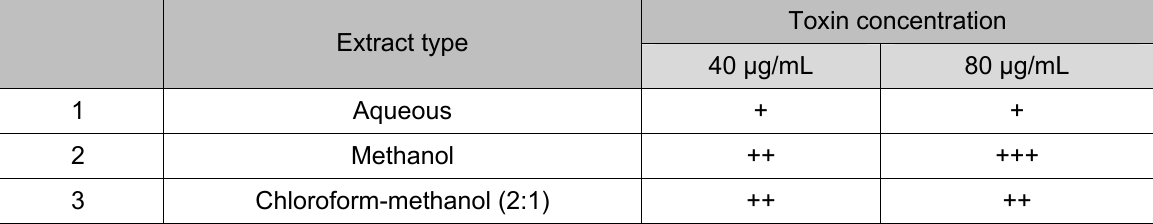
Table 3. Angiogenesis in 9-day-old chicken egg after treatment with methanolic, chloroform-methanol (2:1) and aqueous extracts Toxin concentration Extract type 40 µg/mL 80